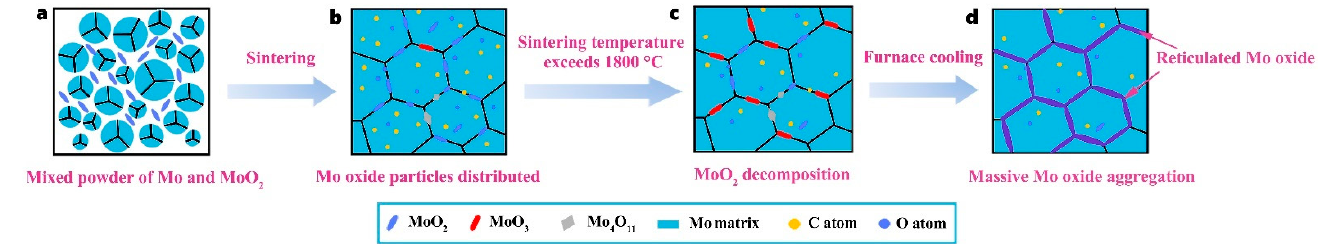
Figure 14. Schematic illustration of the microstructure evolution of O, C, and Mo oxides in the Mo matrix of the O-5 sample during the sintering process: ( a ) mixed powder of Mo and MoO 2 ; ( b ) distributed Mo oxide particles at GBs; ( c ) decomposition reaction of MoO 2 ; ( d ) massive Mo oxide aggregation at GBs.